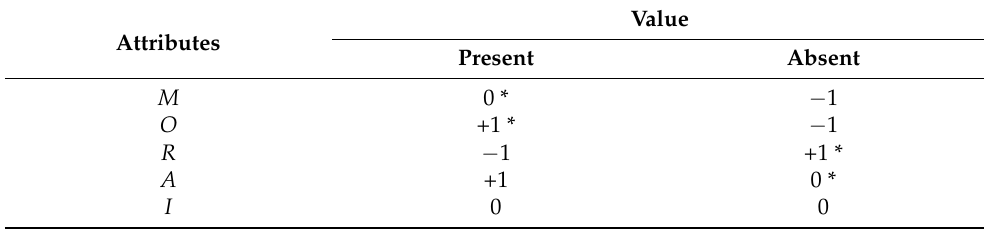
Table 5. Attribute valuation VAM